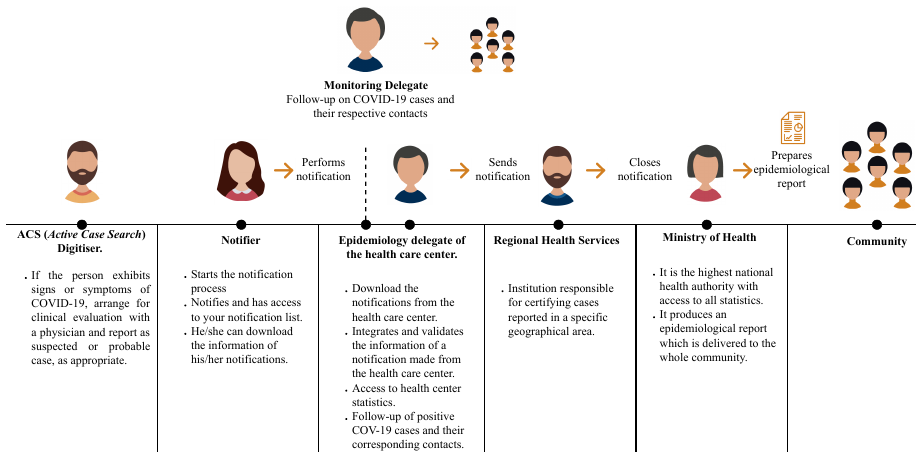
Figure 2. Epidemiological surveillance process conducted in